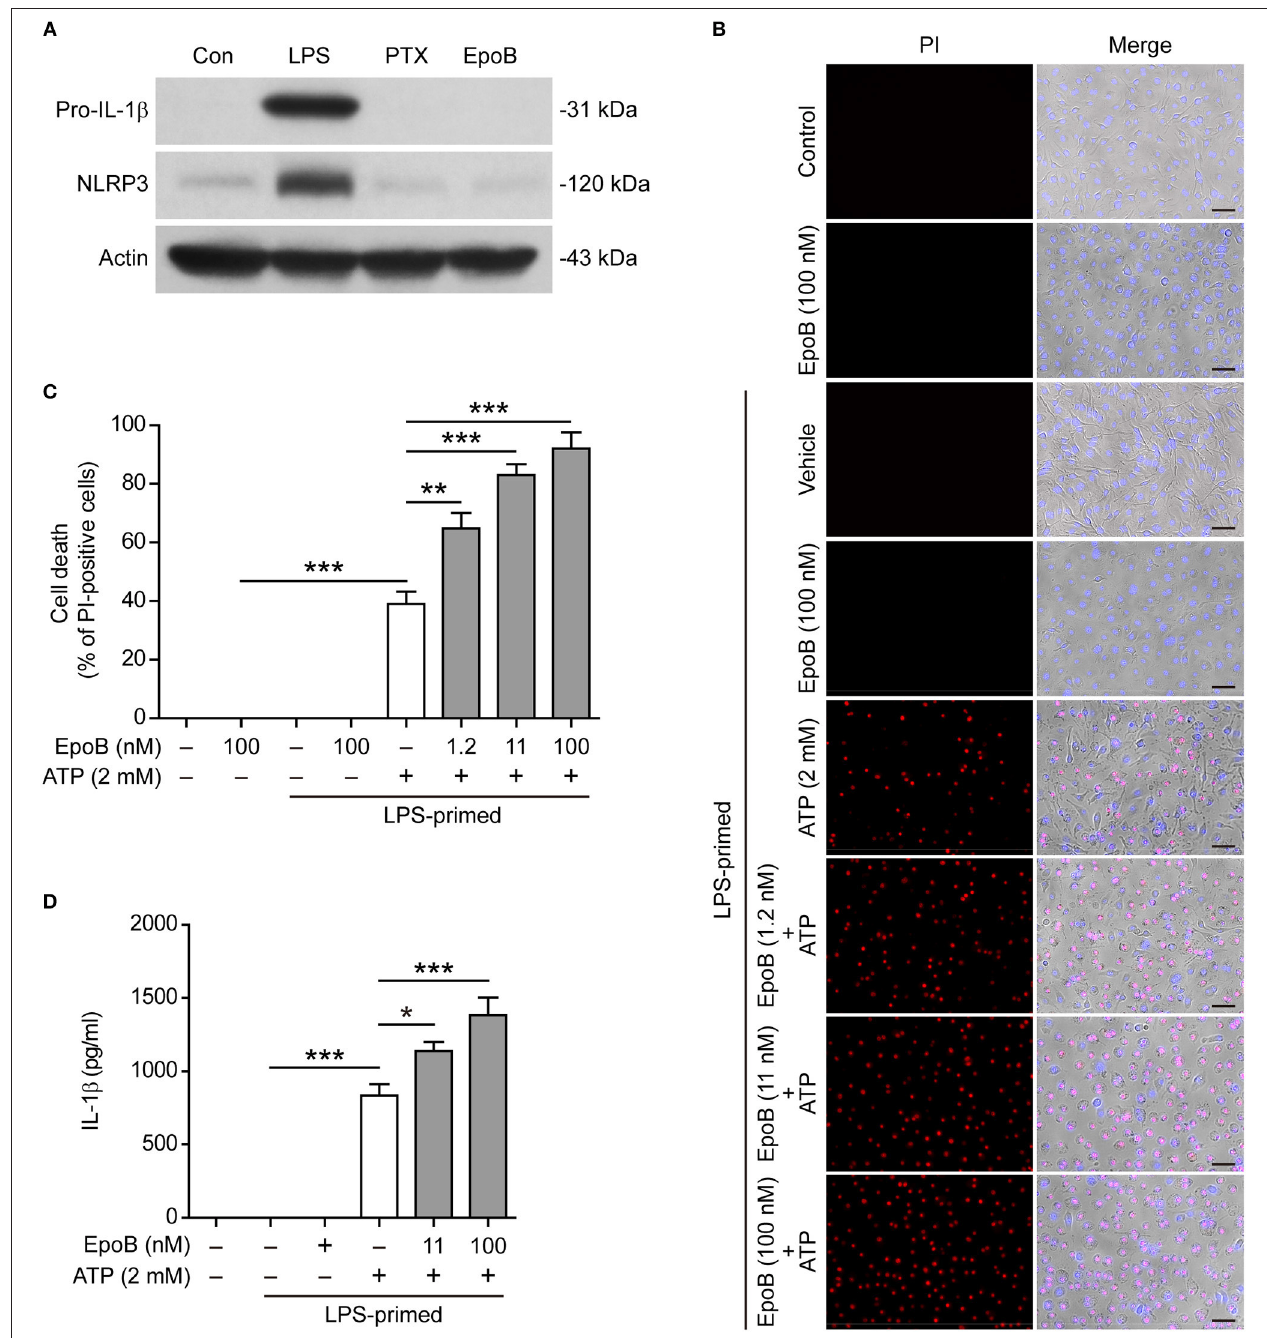
FIGURE 7 | Paclitaxel did not influence macrophage priming in the process of NLRP3 inflammasome activation. (A) BMDMs were treated with LPS (500ng/ml), paclitaxel (100nM) and epothilone B (100nM) for 4h. Indicated proteins in the cell lysates were analyzed by Western blotting. Actin was used as a loading control. (B–D) LPS - primed BMDMs were pre-treated with graded doses of epothilone B for 1h, followed by incubation with ATP (2mM) for 30min. (B,C) Cells were stained by Hoechst 33342 (blue; for all cells) and propidium iodide (PI) (red; for dead cells) for 10min. (B) All images were captured by fluorescence microscopy, and the merged images show PI and Hoechst 33342 fluorescence with bright-field images. One set of representative images of three independent experiments are shown. Scale bars, 50 µ m. (C) PI-positive cells in 5 randomly chosen fields (one field per well) each containing ∼ 100 cells were quantified. The percentage of cell death is defined as the ratio of PI-positive relative to all (revealed by Hoechst 33342) cells. (D) The levels of soluble IL-1 β in culture supernatants were analyzed by cytometric bead array (CBA) assay. (C,D) Data were analyzed using the one-way ANOVA followed by Turkey post-hoc test, which are shown as mean ± SD ( n = 5). * P < 0.05; ** P < 0.01; *** P < 0.001; PTX, paclitaxel; EpoB, Epothilone B.